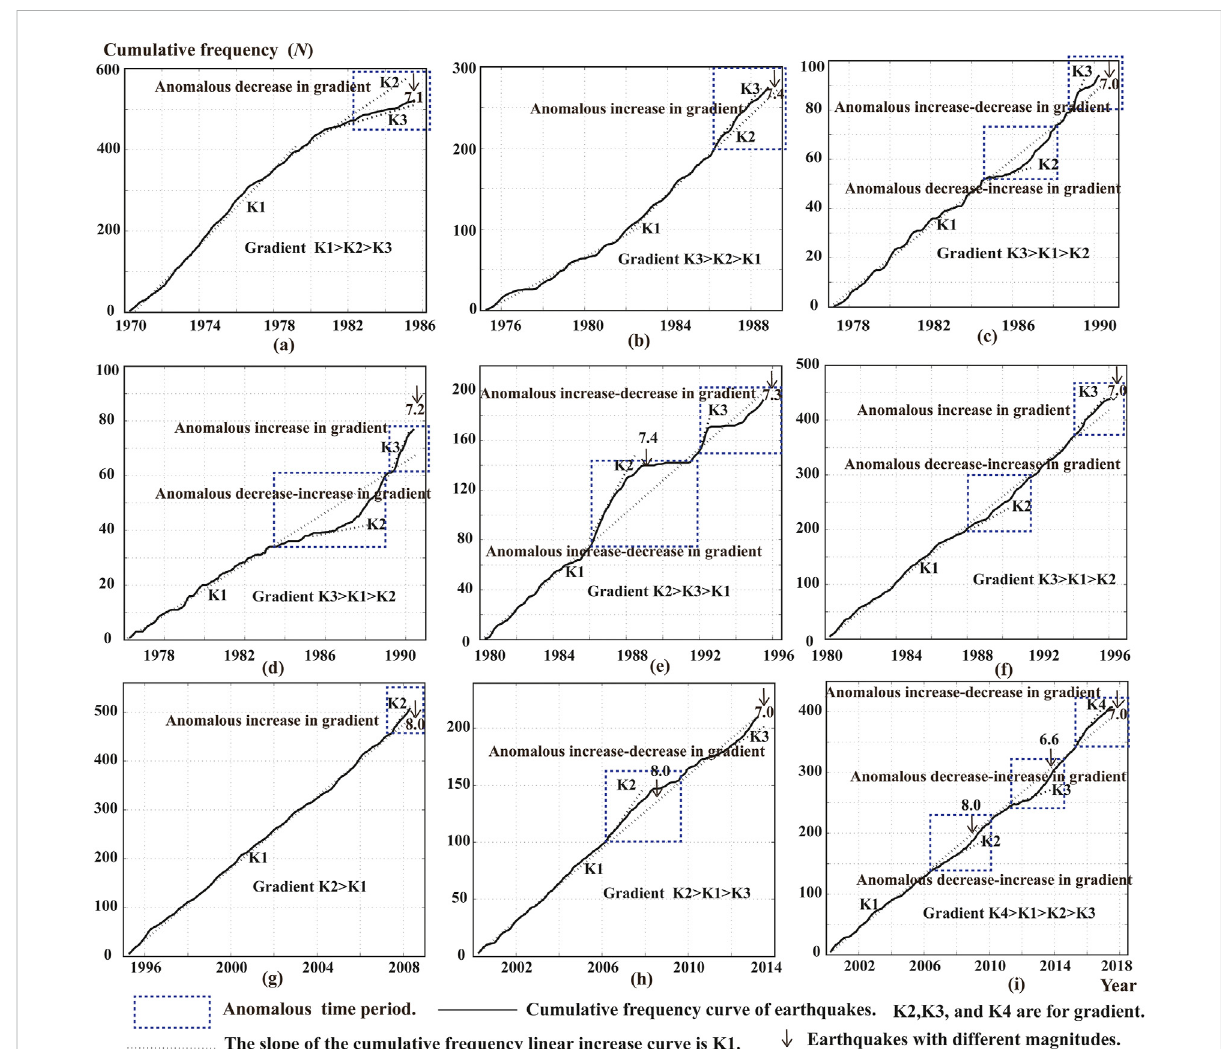
FIGURE 6 Cumulative frequency graphs of 9 M s ≥ 7.0 earthquakes, the green dotted line represents the anomaly, the black arrow represents the magnitude of a M s ≥ 7.0 earthquake, the dashed line represents the slope of a linear increase in cumulative frequency, K1, K2, K3, and K4 are for gradient. (A) 1985 M s 7.1 Wuxia earthquake; (B) 1988 M s 7.6 Lancang – Gengma earthquake; (C) 1990 M s 7.0 Gonghe earthquake; (D) 1990 M s 7.2 Jeminay earthquake; (E) 1995 M s 7.3 Myanmar – China earthquake; (F) 1996 M s 7.0 Lijiang earthquake; (G) 2008 M s 8.0 Wenchuan earthquake; (H) 2013 M s 7.0 Lushan earthquake; (I) 2017 M s 7.0 Jiuzhaigou